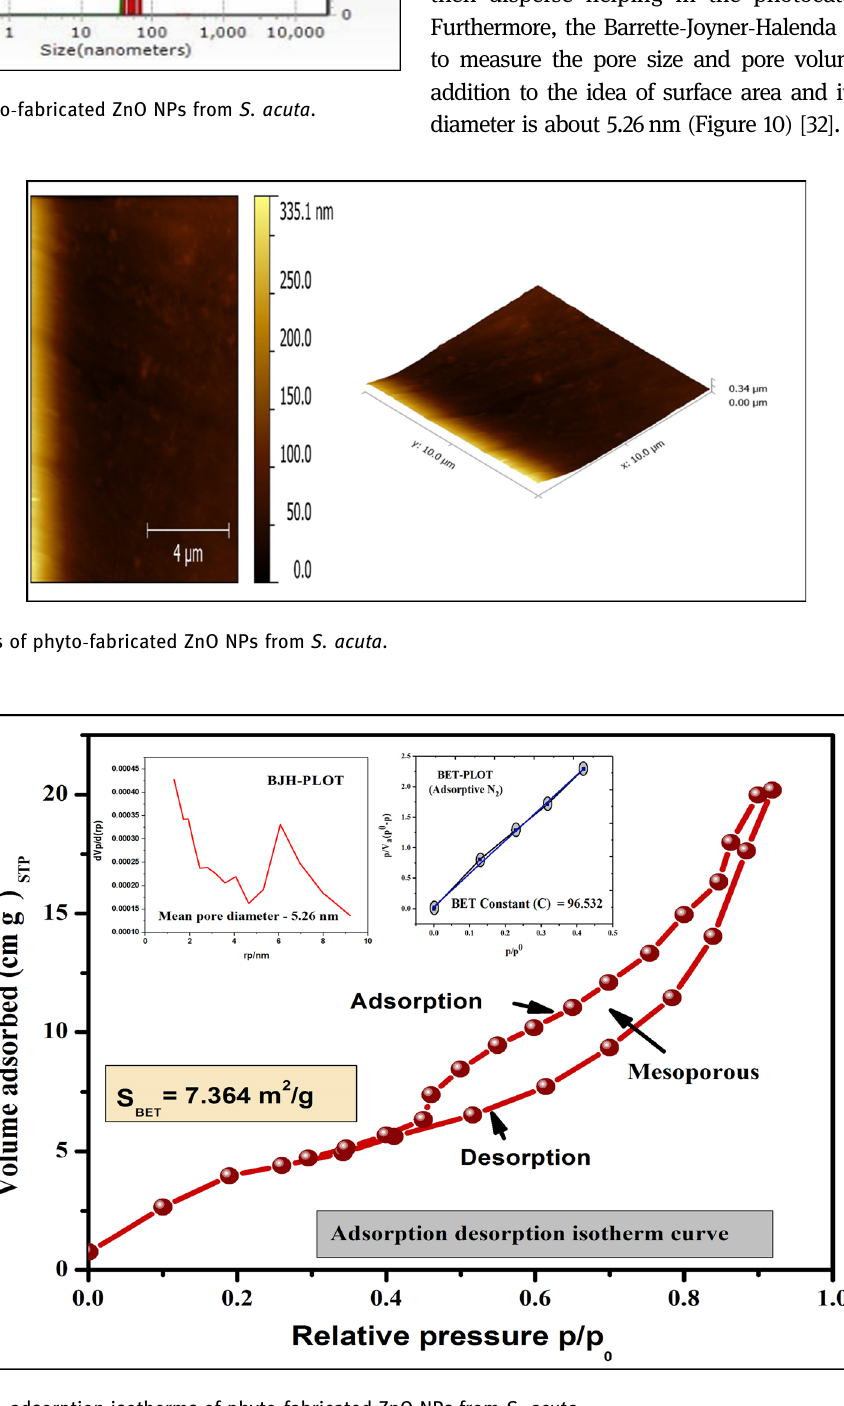
Figure 10: BET and N 2 adsorption isotherms of phyto - fabricated ZnO NPs from S. acuta